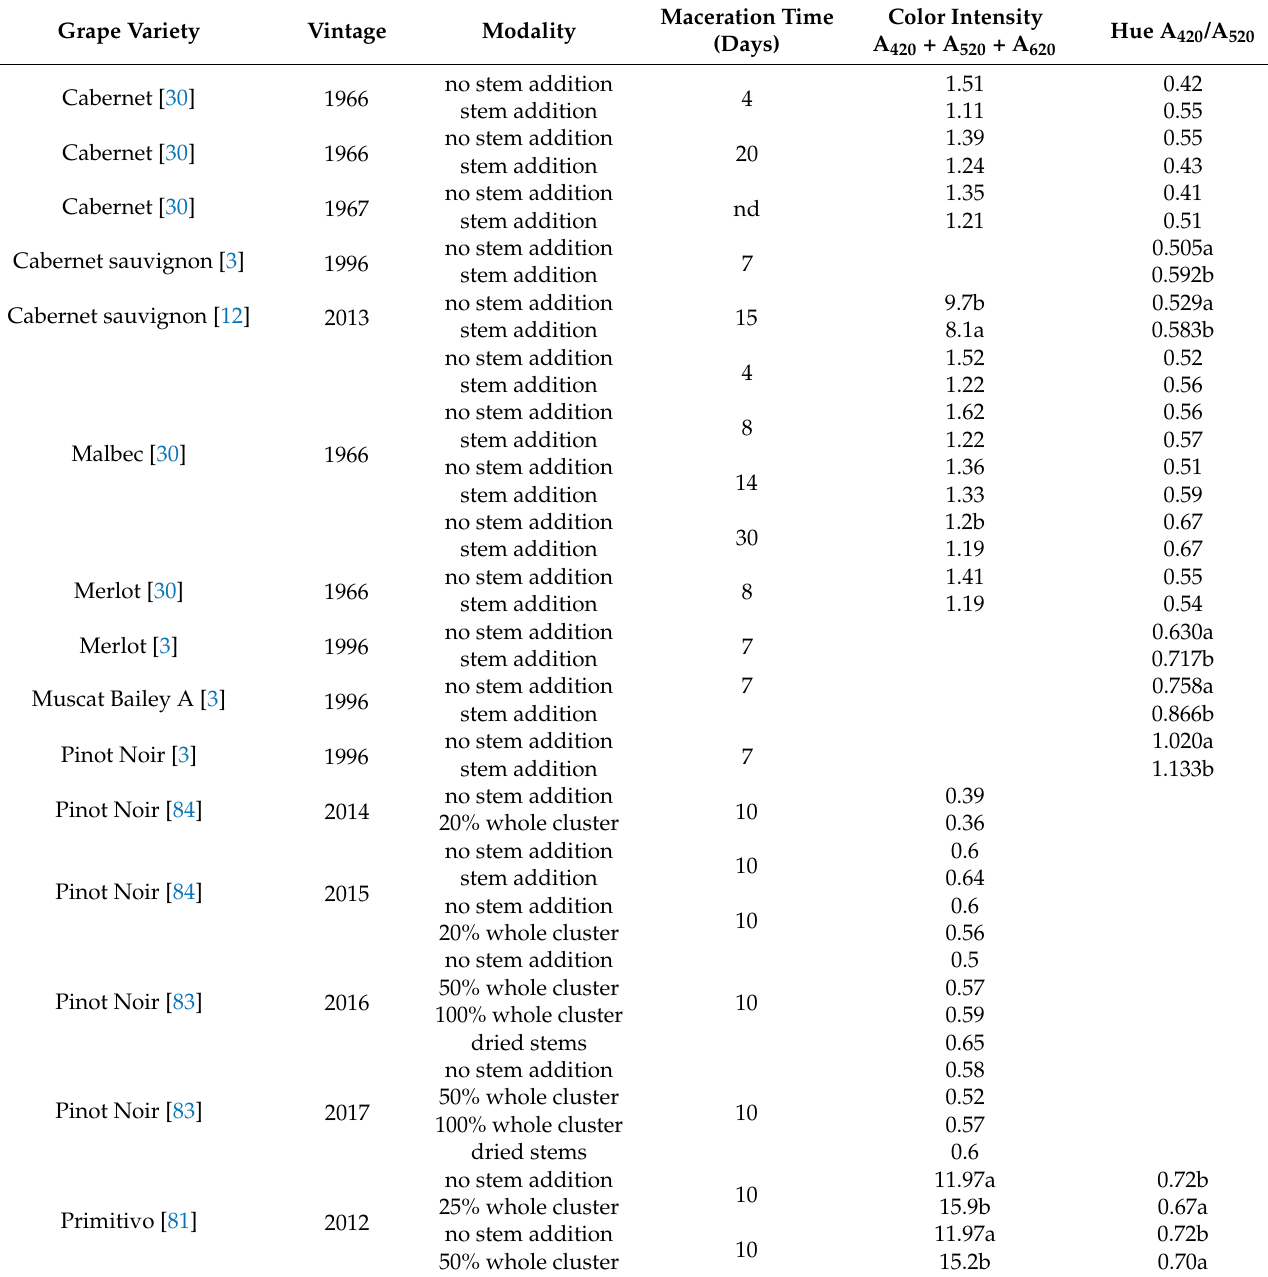
Table 21. Impact of stems on color intensity and hue of wine (for each study, different letters indicate significant statisti- cal